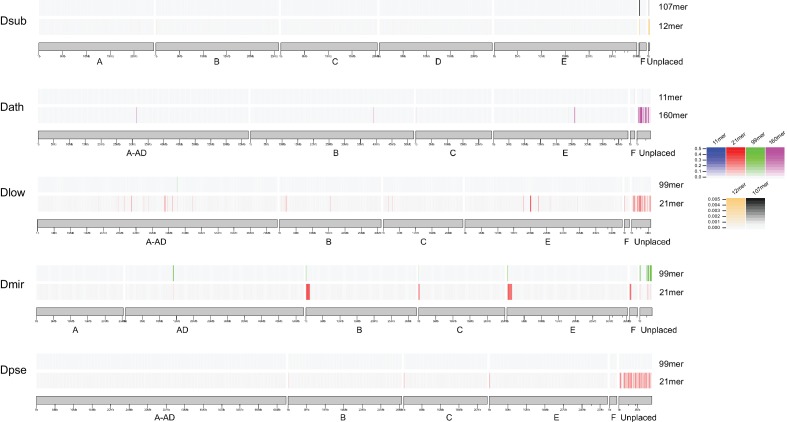
Genomic distribution of inferred centromeric satellite sequences.